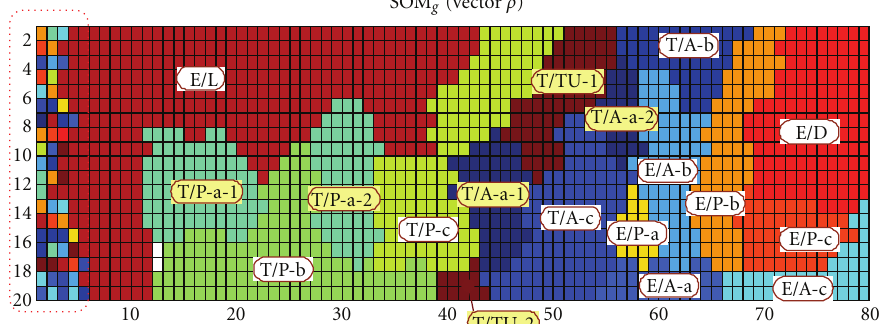
Figure 11: Clusters on the SOM g map (case of vector ρ